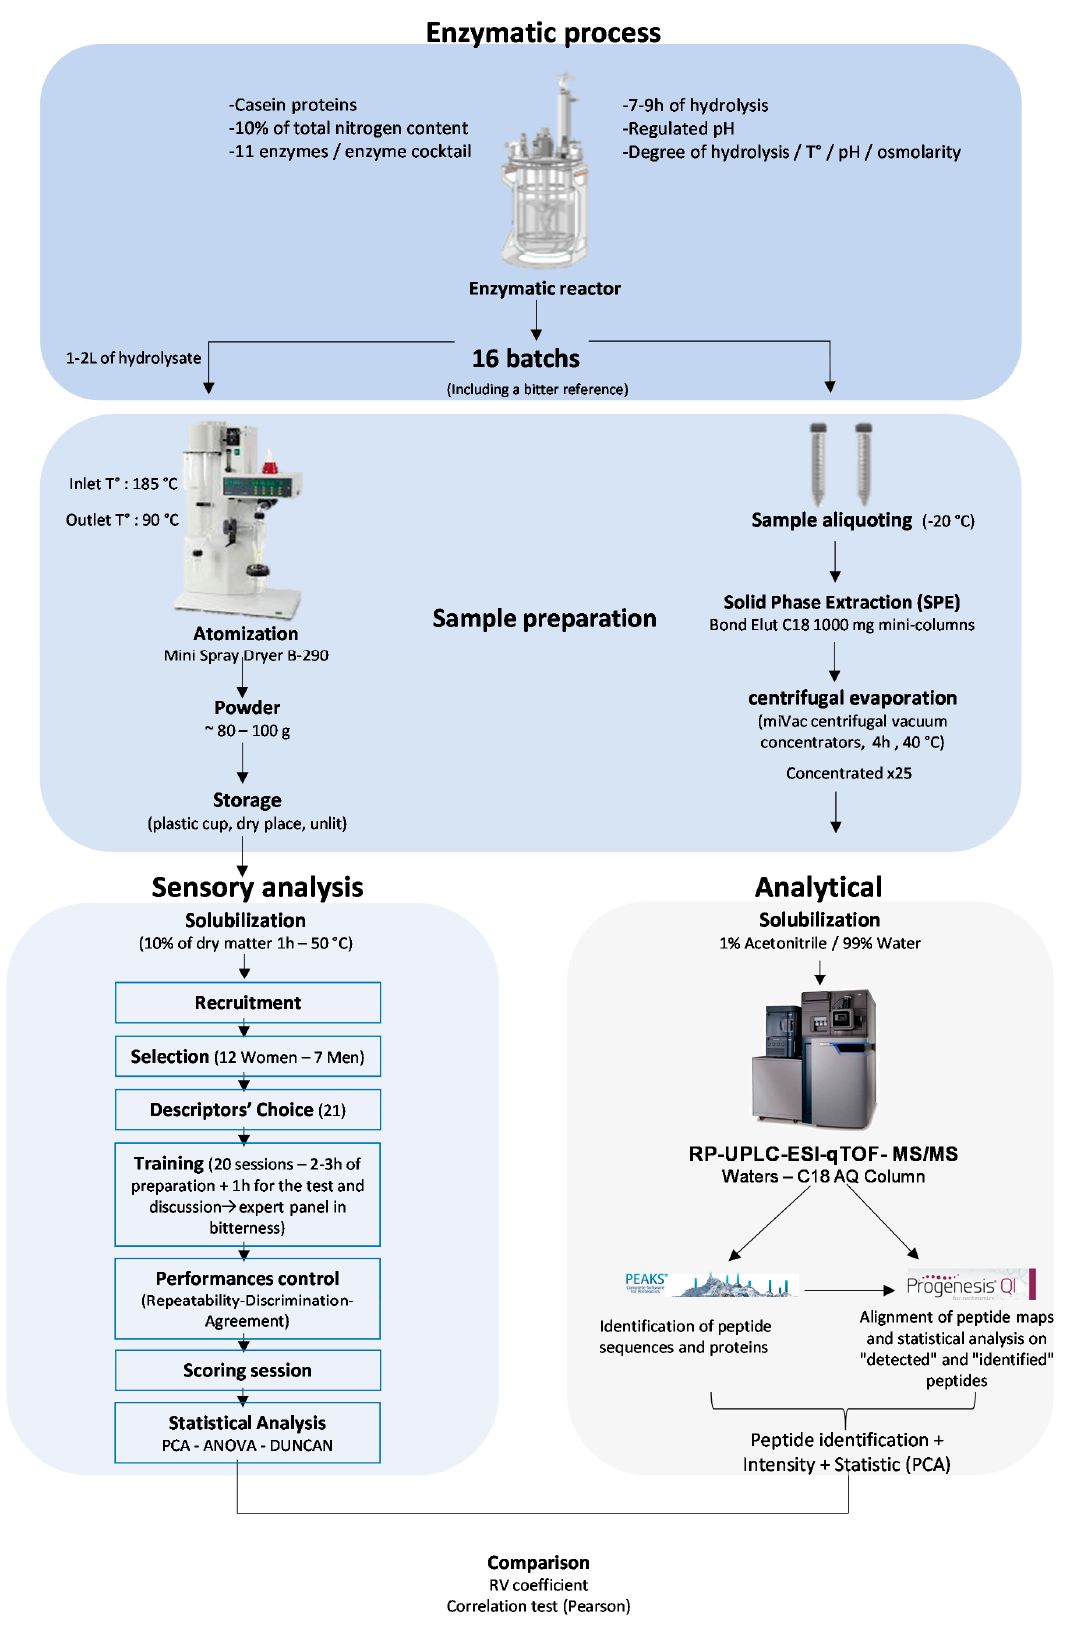
Figure 1. Summary outline of the experimental strategy involving the enzymatic process, sensory evaluation, and mass spectrometry analysis. Principal component analysis (PCA).